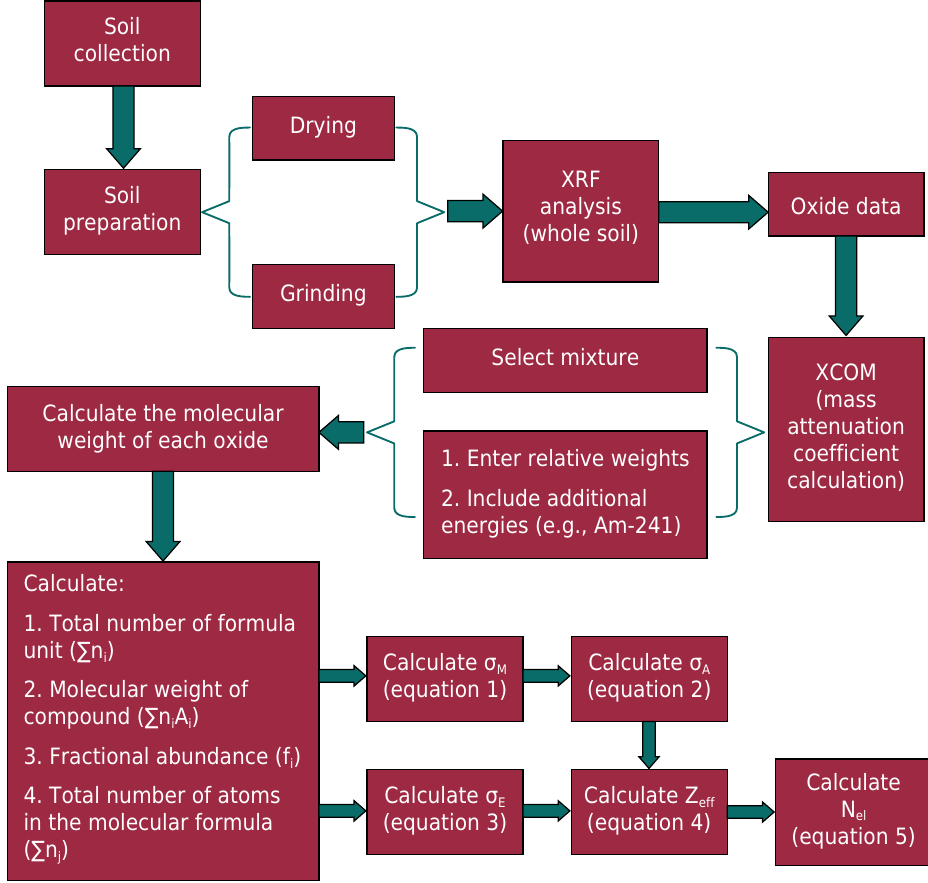
Figure 2. Flowchart of the procedures utilized for calculating the soil radiation interaction parameters.